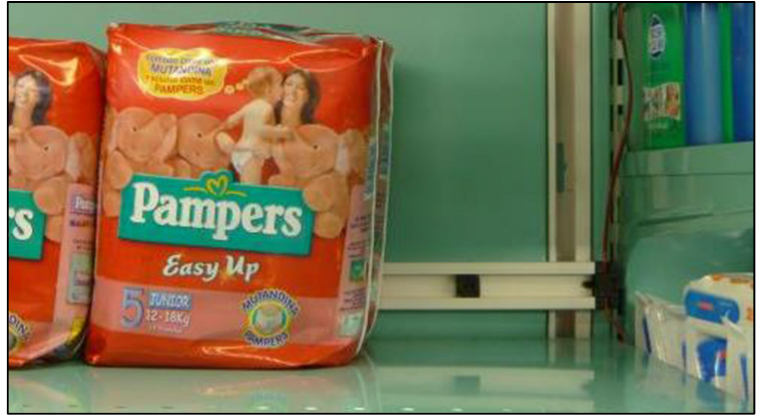
Figure 16. An example of OOS and a real image of sensors installed on the diapers